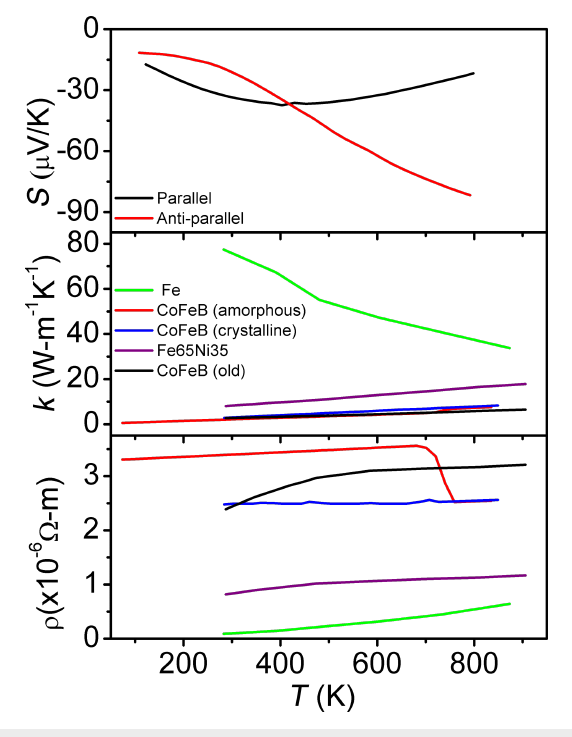
Figure 3: Graph of materials properties used in model construction. From top to bottom: Seebeck values of CoFeB for parallel (ON) and anti-parallel (OFF) states [11], thermal conductivity of materials [8,10], electrical resistivity of materials [8]. Crystalline and amorphous CoFeB values came from literature [12].